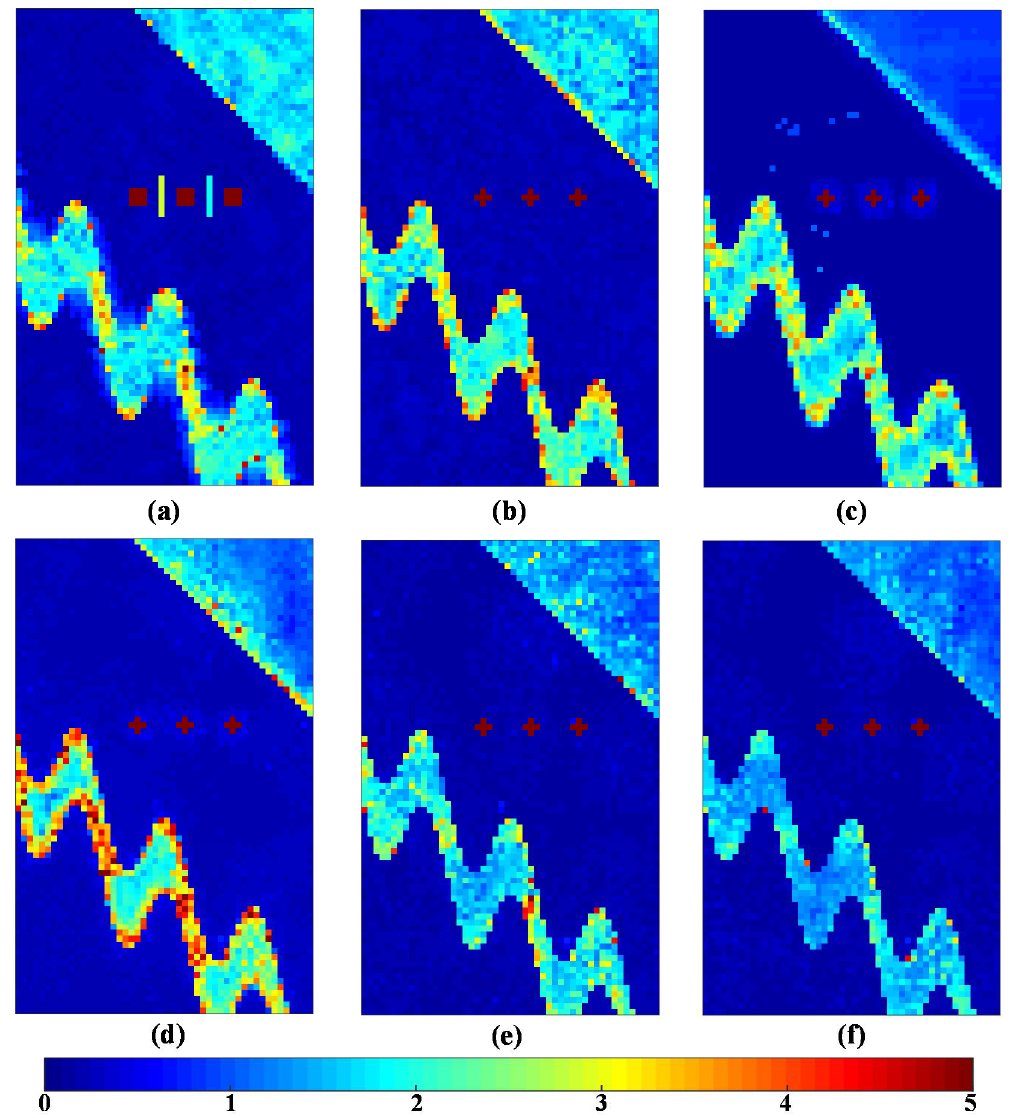
Figure 6. The RMSE of pixel-wise coherency matrices for different filtering methods. ( a ) Refined Lee filter. ( b ) IDAN filter. ( c ) Pretest filter. ( d ) NL-SAR filter. ( e ) The proposed ANLM with single threshold h 0.50 . ( f ) The proposed ANLM with optimal threshold.